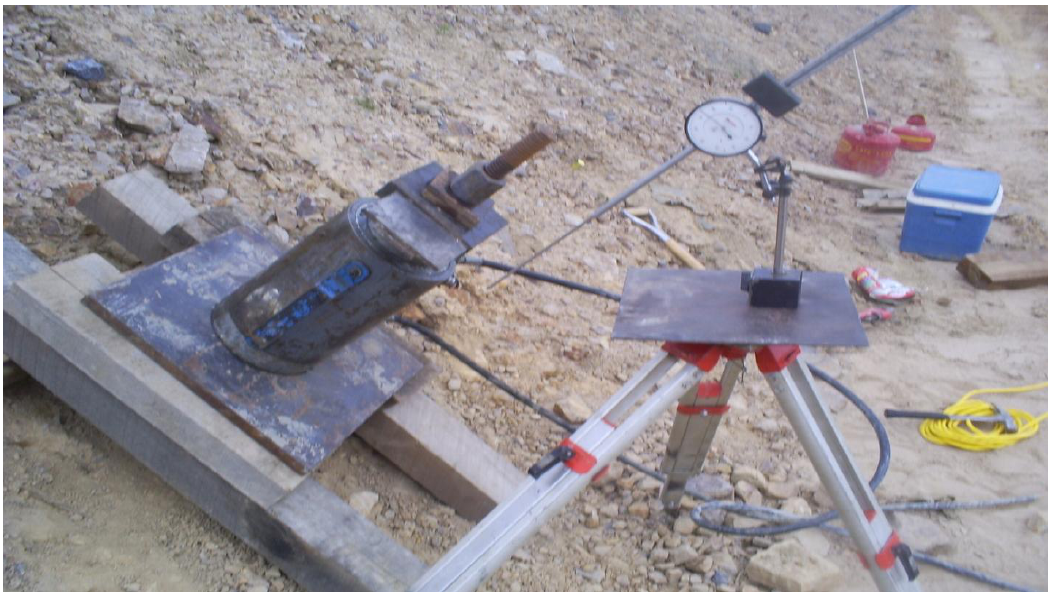
Figure 18. Hydraulic jack being used to proof test a pilot ground anchor. The pictured threaded nut and bearing plate is representative of the nuts and bearing plates used for the production